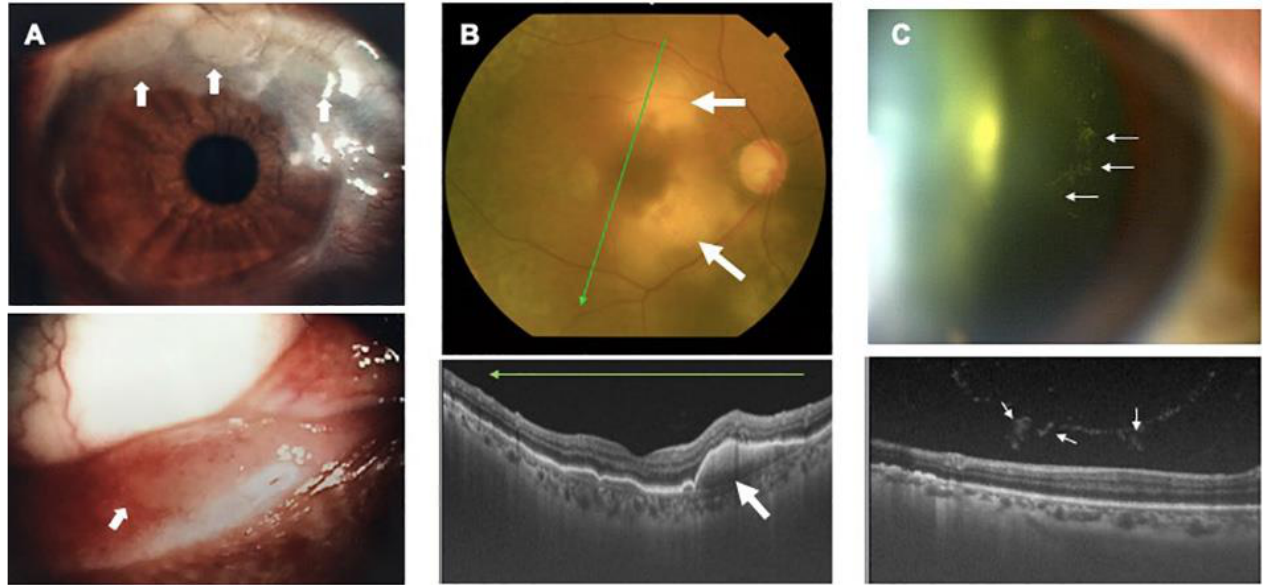
Figure 3. Ocular infiltration in ATL. Multiple knob-like ATL cell ocular infiltrates are seen (KAMOI sign). The KAMOI sign ( A , B ; white arrows) can be seen at the bulbar conjunctiva around the corneal limbus and at the palpebral conjunctiva around the lacrimal punctum ( A ) and in the retina ( B ). Multiple infiltrating ATL cells in the vitreous tend to form clusters ( C ). (Reproduced with permission from Kamoi et al., Cornea. 2016 [62]; Kamoi. Front Microbiol . 2020 [19]).